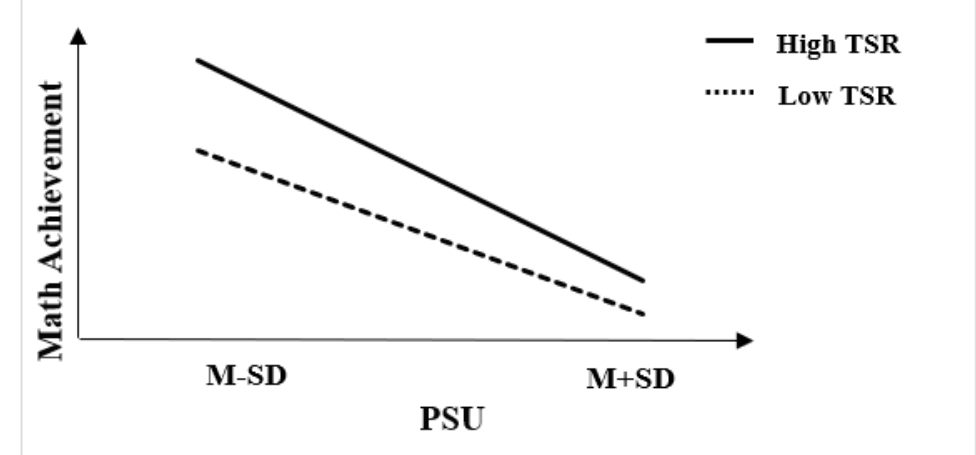
Figure 2. TSRs moderating PSU and math achievement.